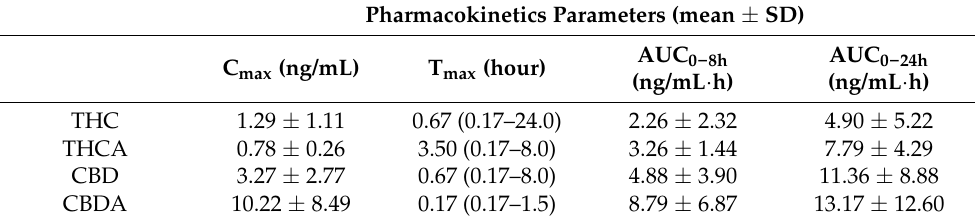
Table 1. Pharmacokinetic parameters of THC, CBD, and their acidic precursors in oral fluid of healthy volunteers administered with 100 mg vaporized medical